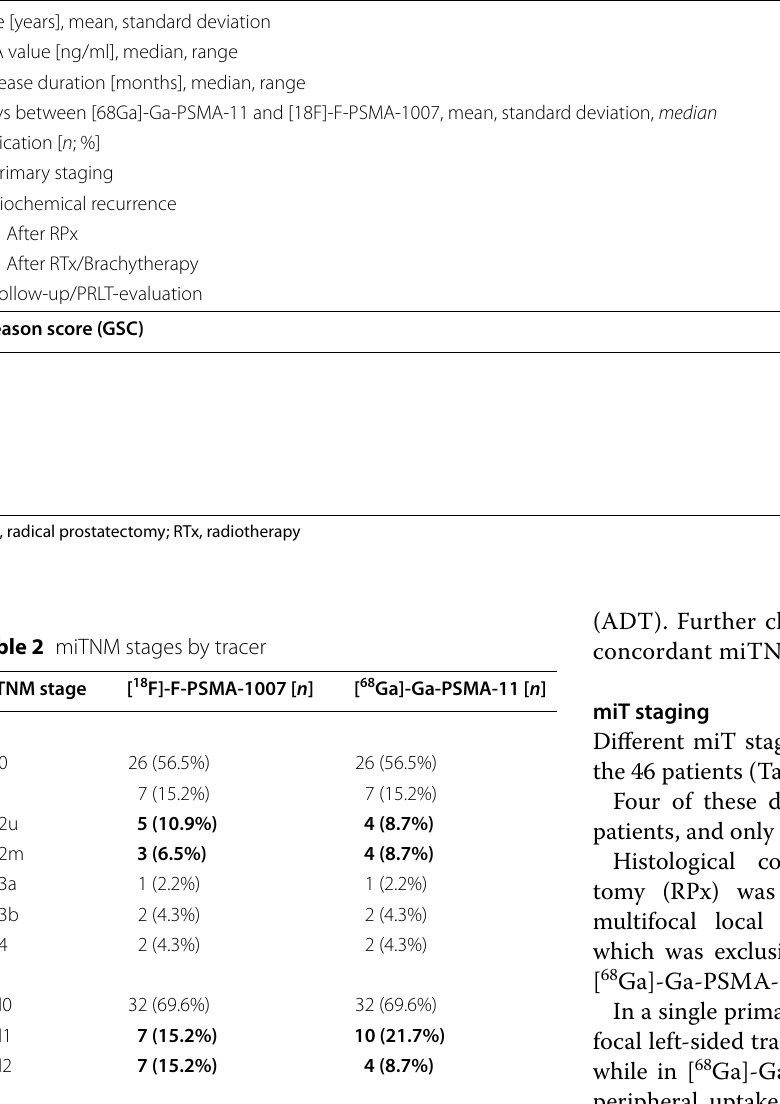
Table 1 Patients’ characteristics